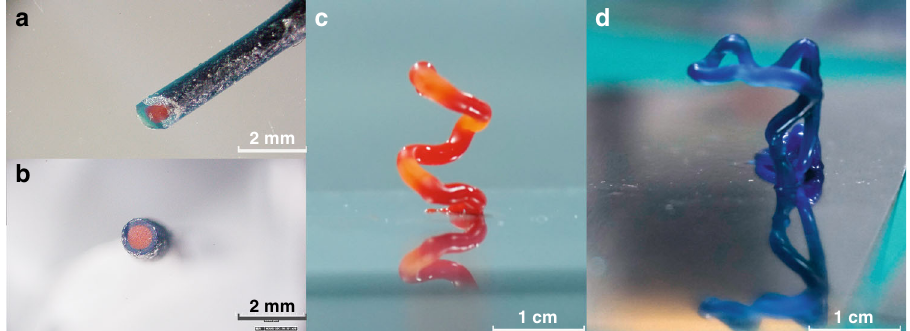
Fig. 4 NIR-DIW-printed multicolor fi lament and colored freestanding structures. a Top view and b side view of core-shell multicolor fi lament, the scale bar is equivalent to 2 mm; c freestanding spiral structure with red pigments; d freestanding M-shaped cantilever structure with blue pigments, the scale